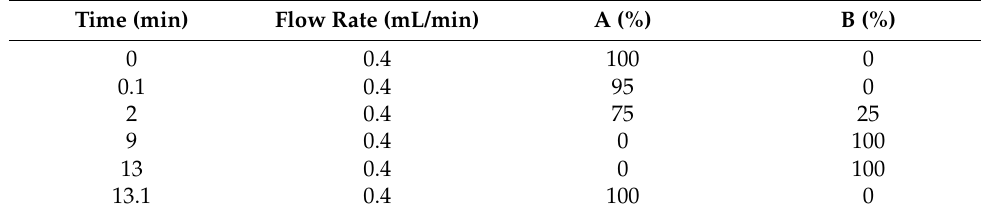
Table 2. Gradient of mobile